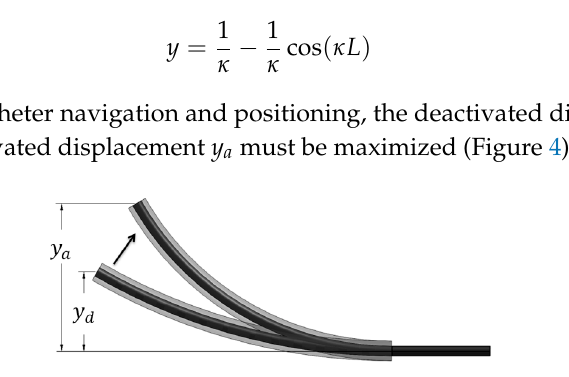
y ) states. Figure 4. Composite actuator in its deactivated ( y d ) and activated ( y a ) a